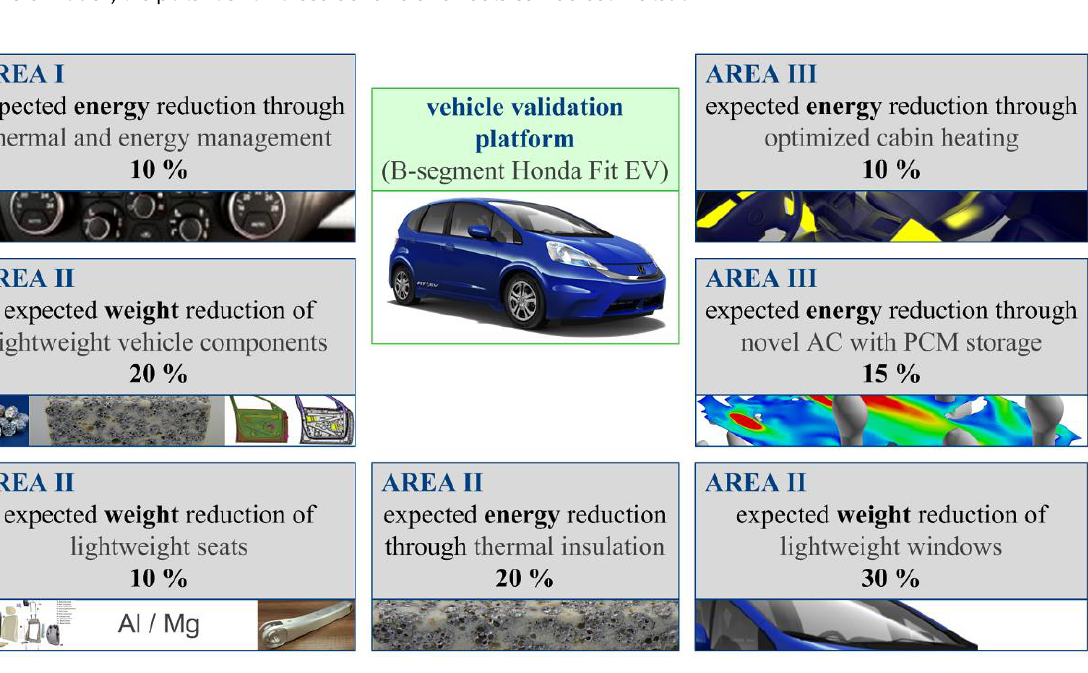
Figure 6. Expected reduction of energy consumption and weight in each of the three areas of the QUIET project Starting point is the Honda Fit EV 2017 baseline for which a driving range increase of at least 25 % is prescribed (accompanied by enhanced thermal comfort and maximized energy efficiency) by means of following enhancements, specified